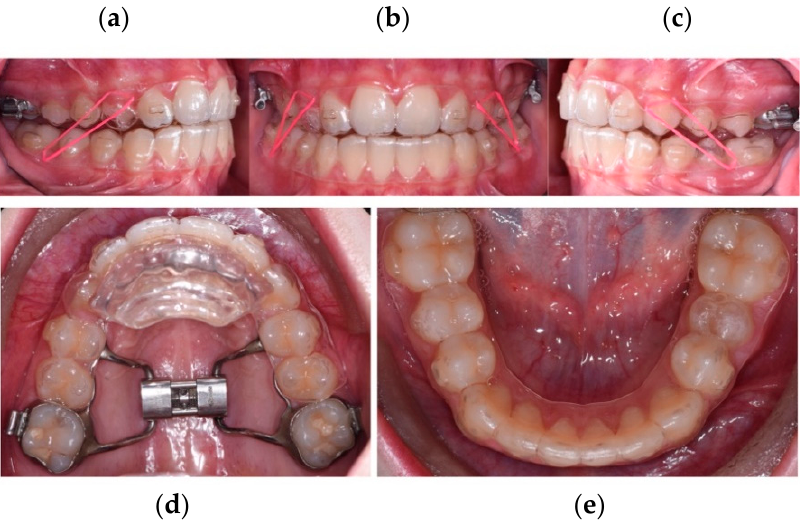
Figure 3. ( a – e ) Rapid palatal expander (RPE) and class II elastics used simultaneously with F22 Young.